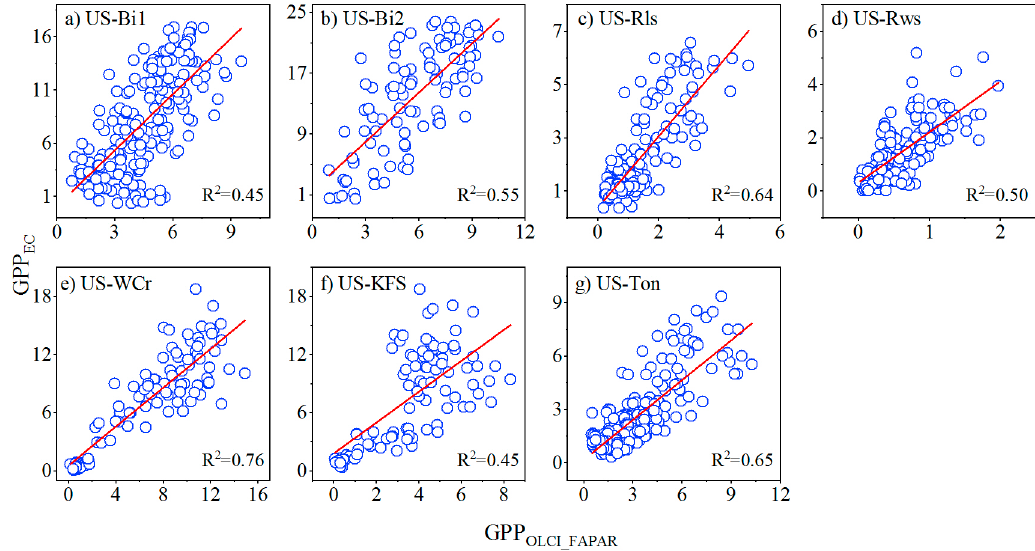
Figure 5. Scatterplots between GPP EC and GPP OLCI-FAPAR (GPP for the Ocean and Land Colour Instrument FAPAR product) for all sites in 2017 and 2018. Significance levels: p < 0.001. ( a – g ) represent the sites the same as Figure 2.